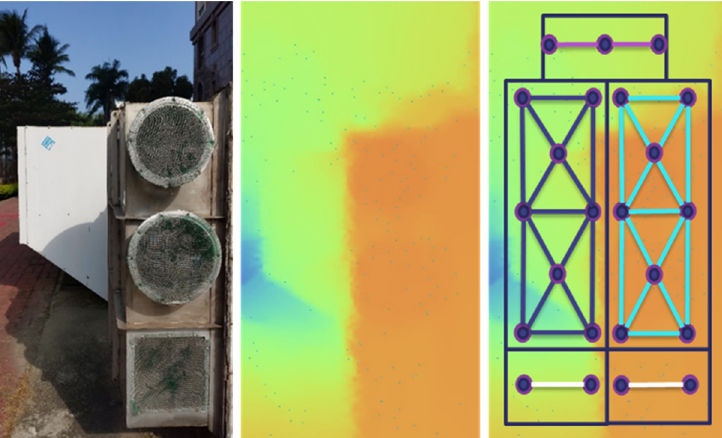
Figure 4. Original image ( left ), generated depth map at 1.6 m ( middle ), depth map with overlaid point coordinates on different locations ( right ).